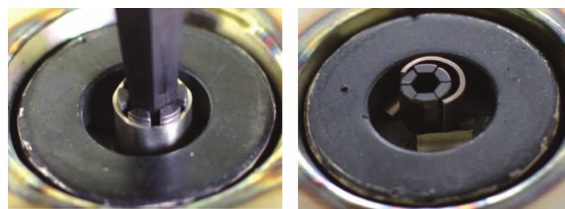
Fig. 5. The mandrel test performed with a ductile (left) and a brittle sample